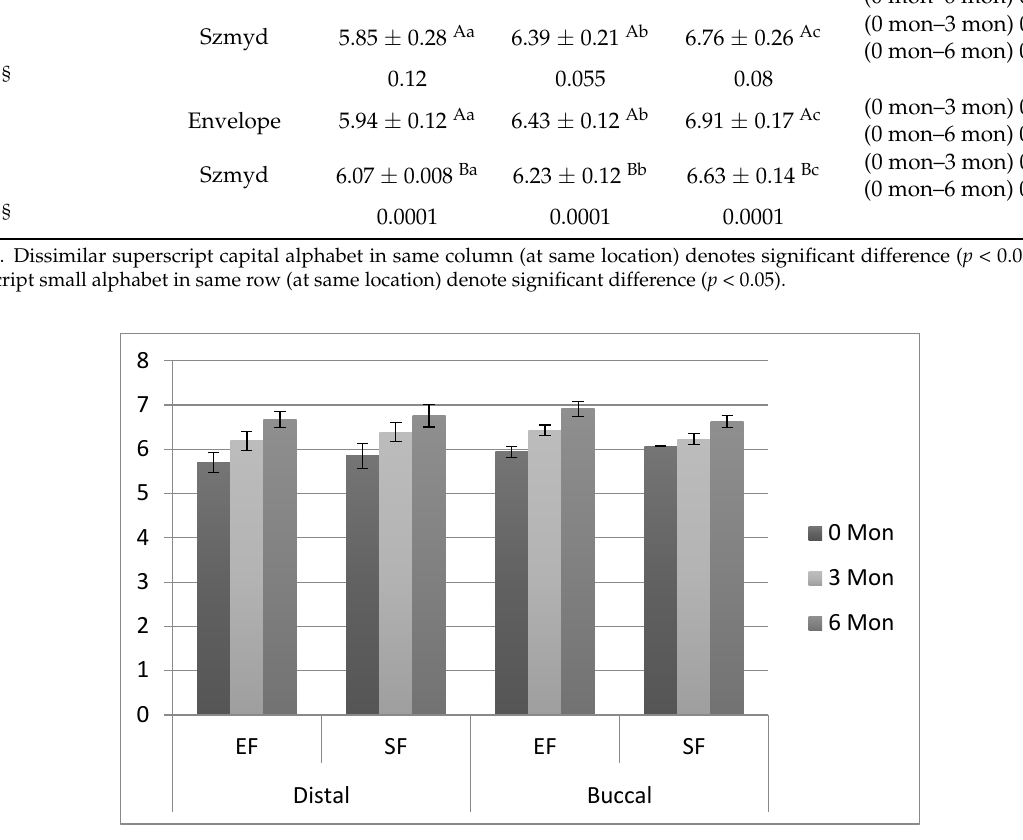
Figure 3. Comparison of clinical attachment loss (means and SD) in mm, among study groups. EF: Envelope flap, SF: Smzyd flap.